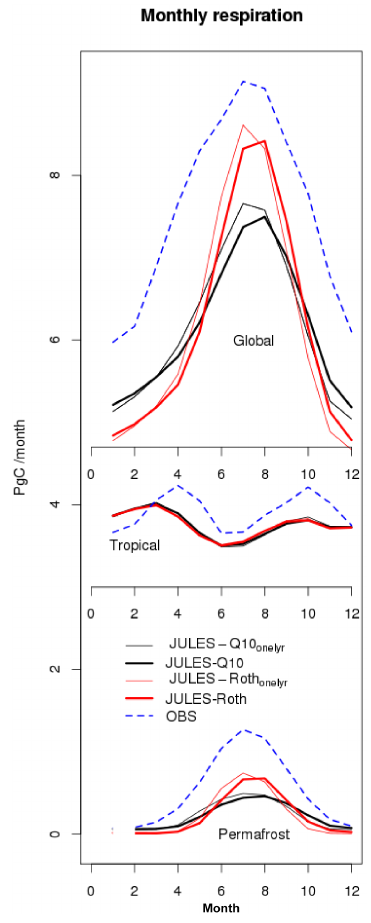
Figure 8. Seasonal cycle of total monthly respiration for the three main regions considered in this